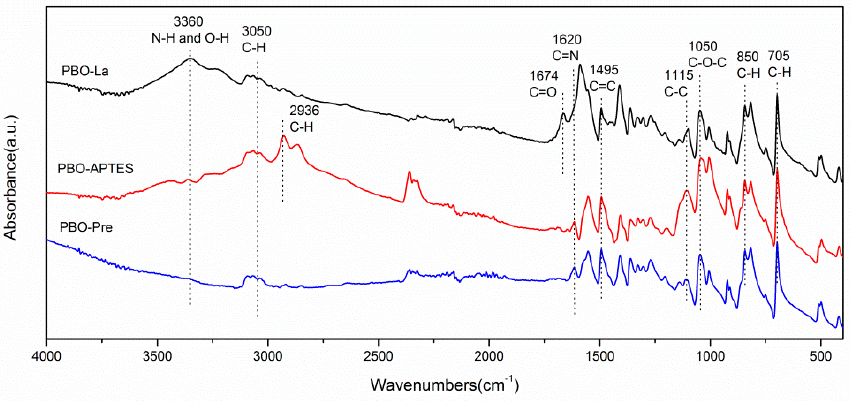
Figure 5. ATR-FTIR spectra of the PBO-Pre fiber, the PBO-APTES fiber, and the PBO-La fiber.